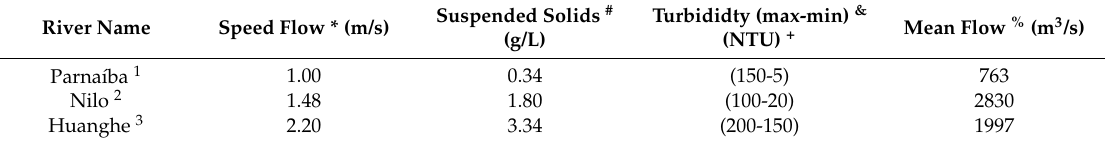
Table 2. Characteristics of Rivers chosen. Table 2 . Characteristics of Rivers chosen.